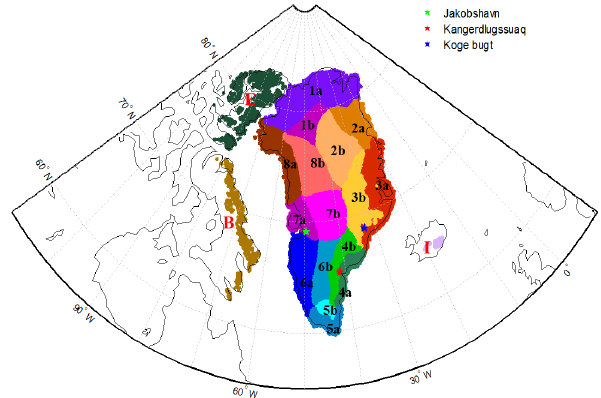
Figure 1. The GrIS mascon layout, based on the drainage system definition by Zwally (2012). A mascon with the same digits refers to a region belonging to the same drainage system. The “a” and “b” terms indicate the GrIS margin ( < 2000m) and GrIS interior ( ≥ 2000m), respectively. There are 16 GrIS mascons and 4 neigh- bouring Arctic mascons. The locations of the three largest discharge outlets are marked with a star, i.e., Jakobshavn (green), Kangerd- lugssuaq (red) and Koge Bugt (blue) glaciers. The glacier surface area is defined in the RACMO2.3